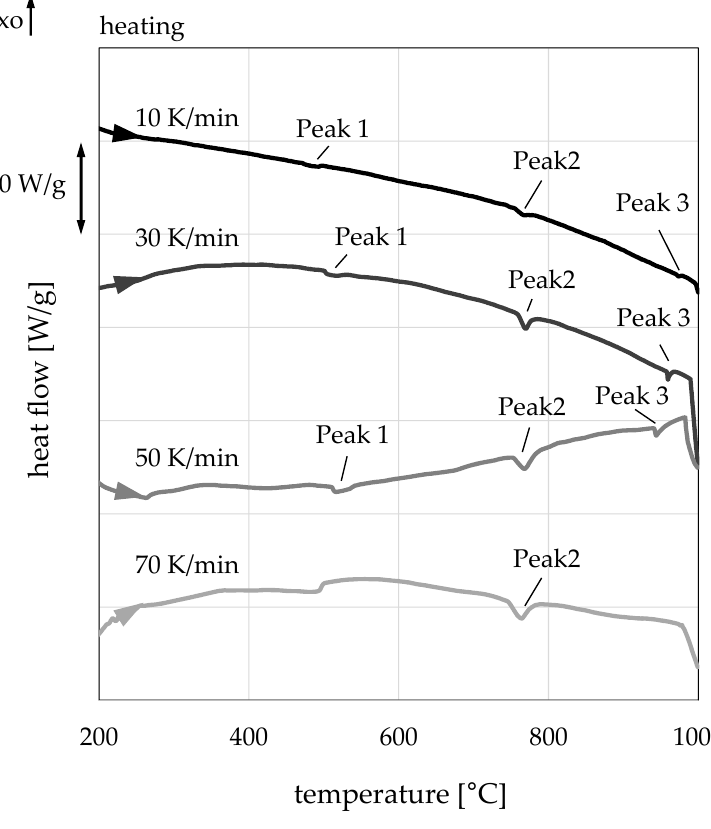
Figure 4. Example of heat flow curves of DSC measurements of micro samples for a heating rate of 10, 30, 50 and 70 K/min.